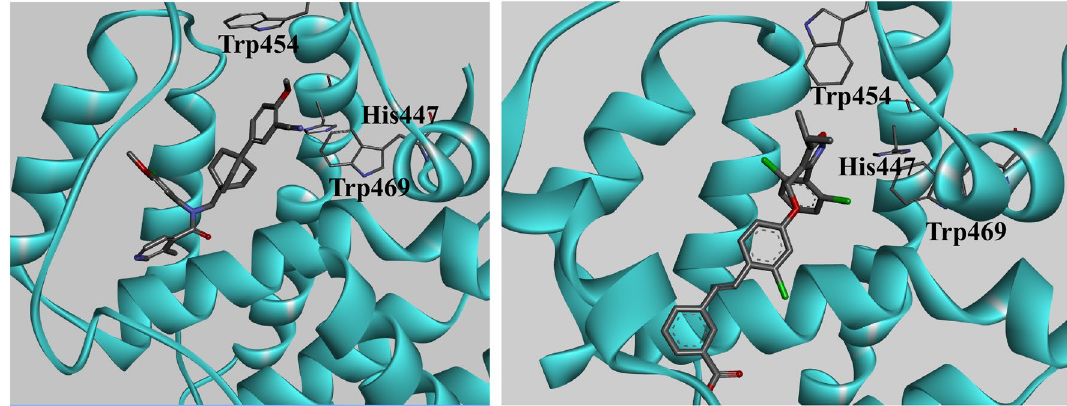
Figure 5. ( a ) Model showing the docking of compound 20p into the FXR ligand binding domain obtained from the X-ray crystal structure PDB 1OSH. ( b ) GW4064 ( 4 ) is shown for comparison